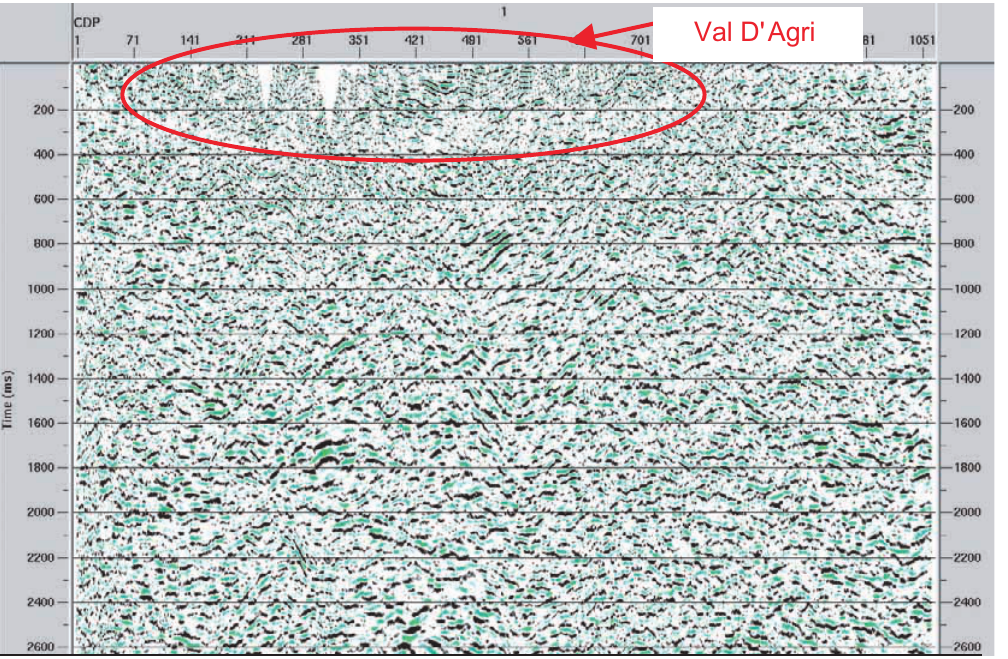
Fig. 2. Example of conventional seismic image across Val